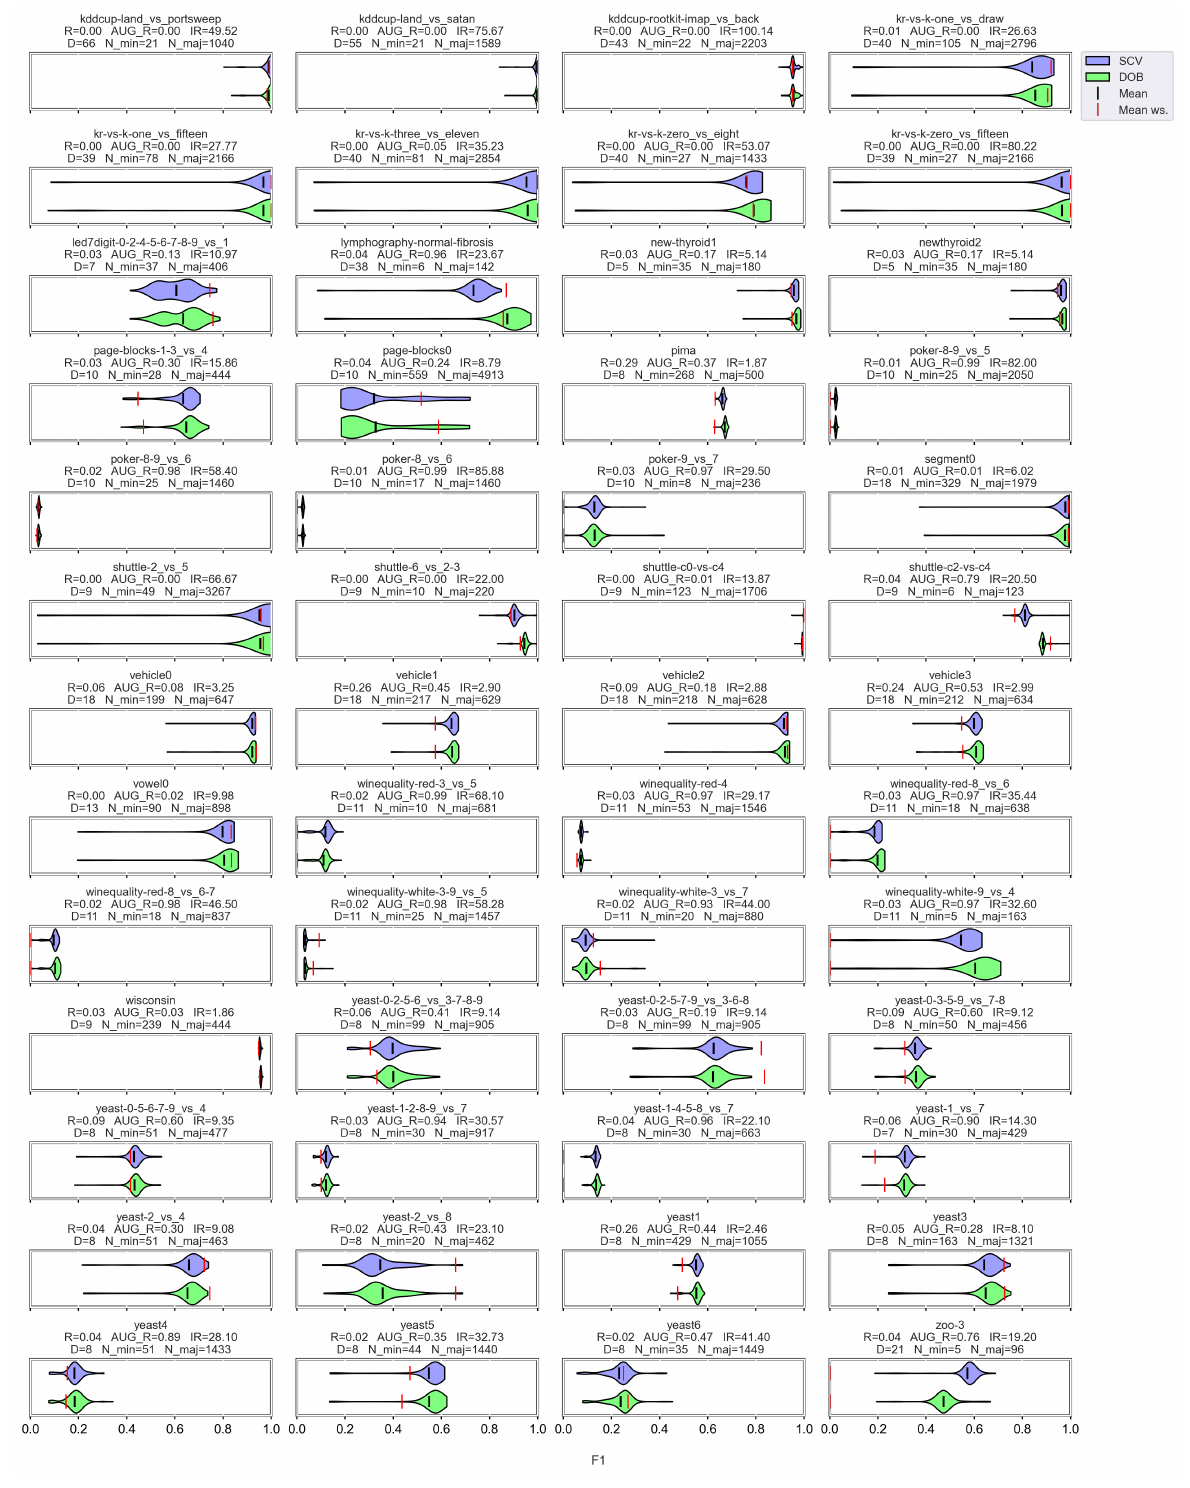
Figure A4. F 1 values resulted by the SVM classifier and the named oversamplers per data set of